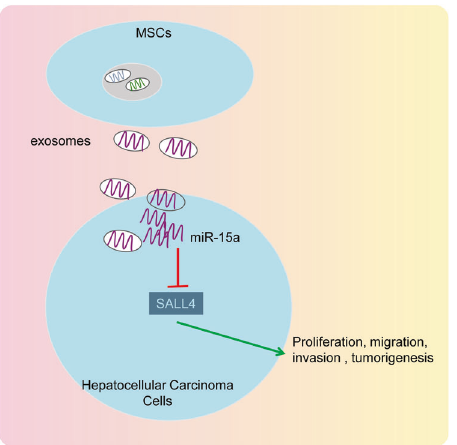
Fig. 7 A schematic for the mechanism and function of MSC- derived exosomal miR-15a in HCC via SALL4. MSC-derived exosomes were capable of transmitting miR-15a, which thus inhibited the expression of SALL4, and thereby inhibiting the proliferation, migration, and invasion of HCC cells in vitro as well as retarding the tumorigenesis in vivo, ultimately preventing the occurrence of